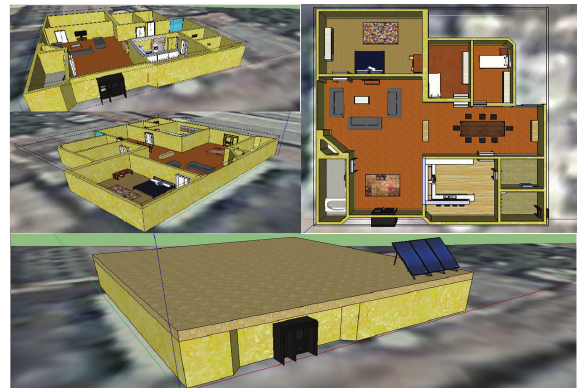
Figure 5: Three-dimensional model and representation of a typical urban house in